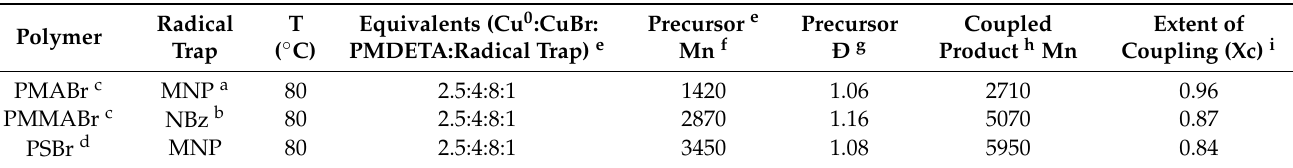
Table 4. Characteristics of polymer precursors and results of their RTA-ATRC reactions. These correspond to Trials 11, 16, and 25 in earlier